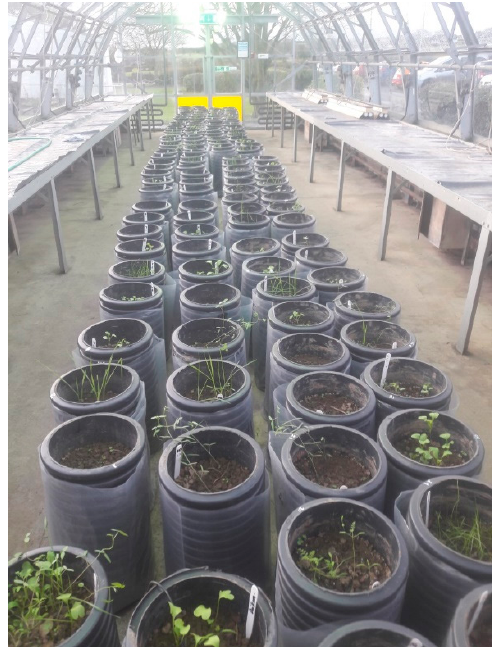
Figure A3. Photo of cover crops emerging.